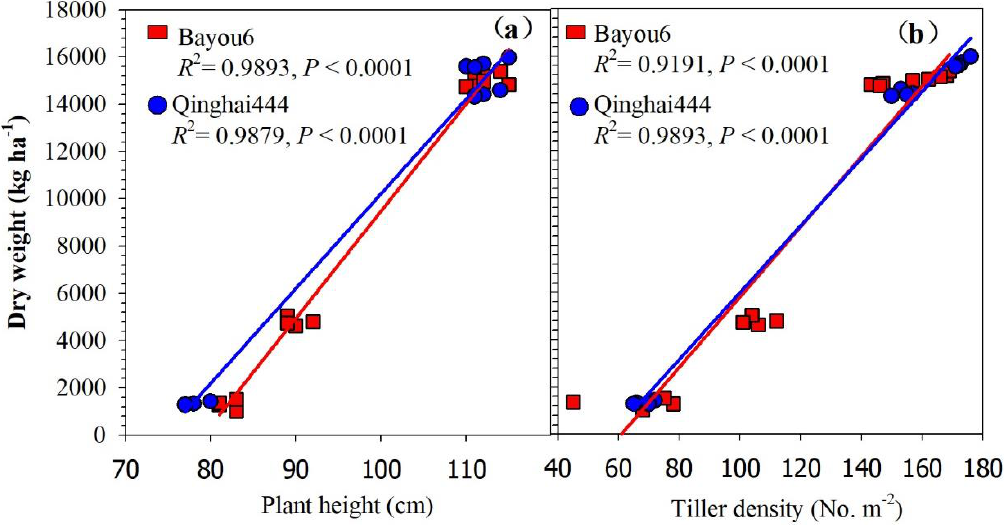
Figure 5. The cumulative dry weight ( a , c ) for the different cutting stages and the growing stages by Zadoks code ( b , d ) for those oats without cutting during the growing season. Data are means ± SE ( n = 4).